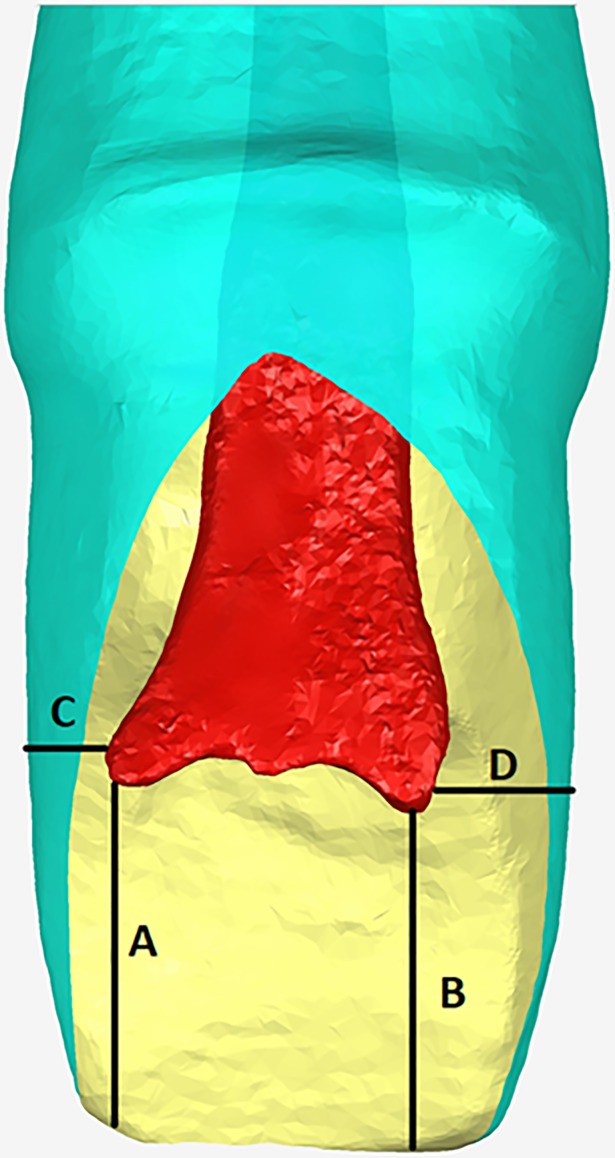
The distance from medullary angle to incisal edge or adjacent surface of the specimen which was prepared for all ceramic crown.(A) The distance from mesiopulpal angle to incisal edge; (B) The distance from distopulpal angle to incisal edge; (C) The distance from mesiopulpal angle to mesial adjacent surface; (D) The distance from distopulpal angle to distal adjacent surface. The red part in the Fig 4 was the medullary chamber of the crown, and the green part was a specimen prepared for all ceramic crown.